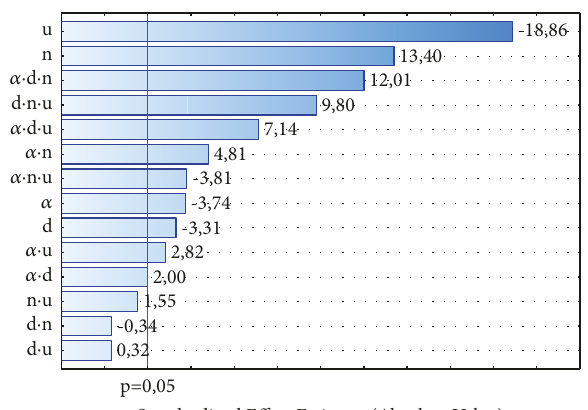
Figure 4: Pareto chart of standardised effects of the regression model of the screw drive torque M